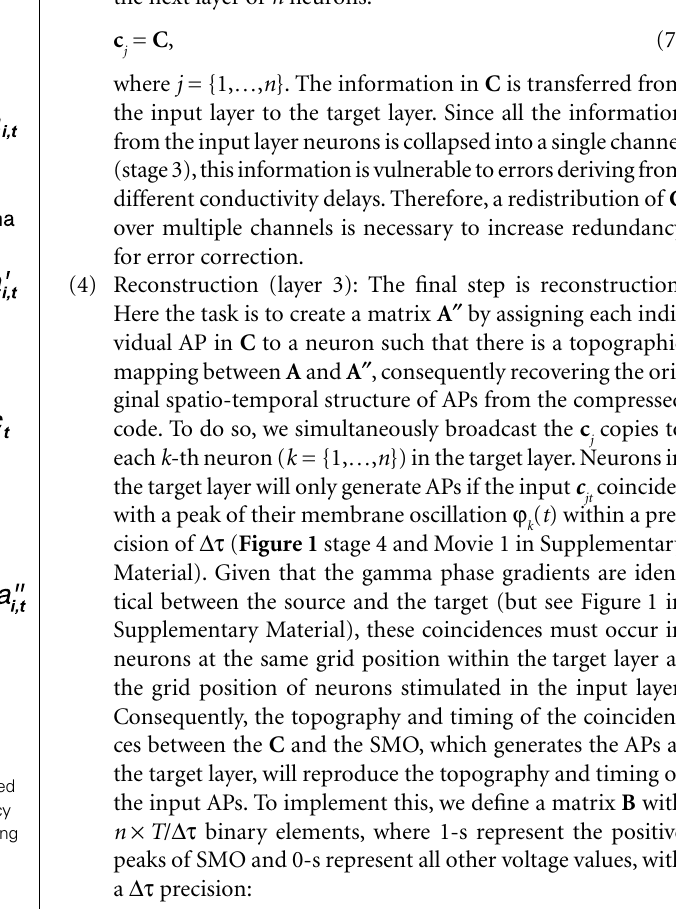
A “1” in position ′ a represents an AP for neuron i at time t i i , τ while a “0” represents the lack of AP ( Figure 1 stage